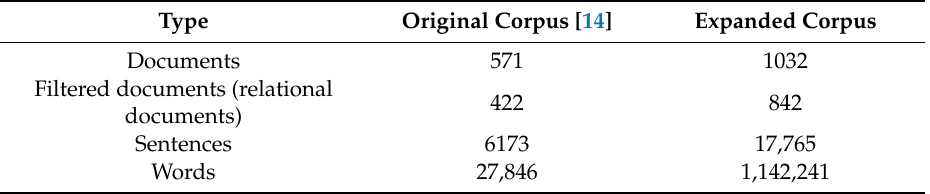
Table 7. Di ff erences between original corpus and expanded corpus.